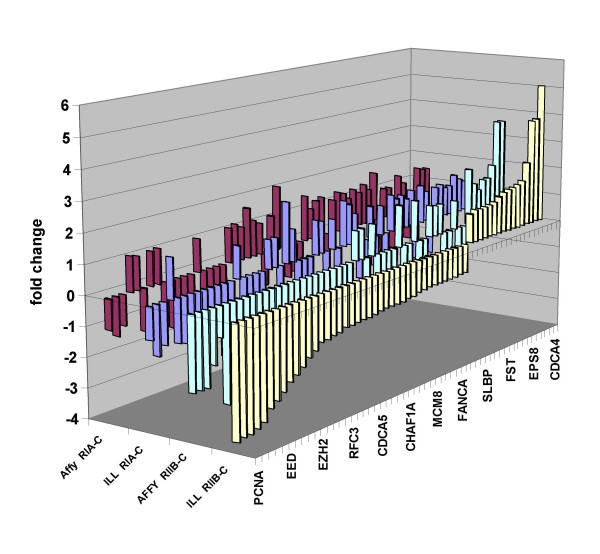
Graphical representation of a subset of genes taken from one of the genelists tested by GSMA ((Vernell_PRB_Clstr2) and found to be negatively enriched for down-regulated genes in RIIβ transfected cells but not in RIA transfected cells, each relative to parental cells. Fold changes (fc) derived from either the Affymetrix or Illumina platforms are shown. Featured genes include those involved in cell division.